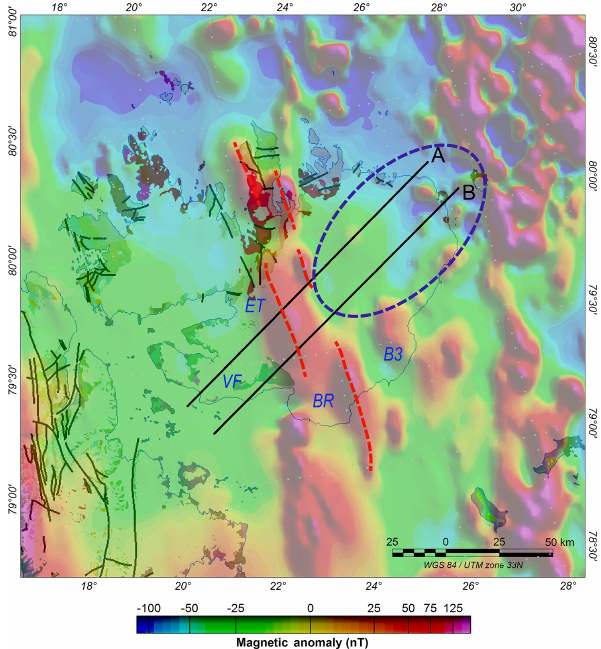
Figure 7. Profiles A and B, as defined in Fig. 2, against the mag- netic anomaly and NPI geological map. Dashed red lines represent deep intrusion trends across Austfonna and the blue circle repre- sents the change of basement seen on the lines modelled (B3: Basin 3; ET: Etonbreen; BR: Bråsvellbreen; VF: